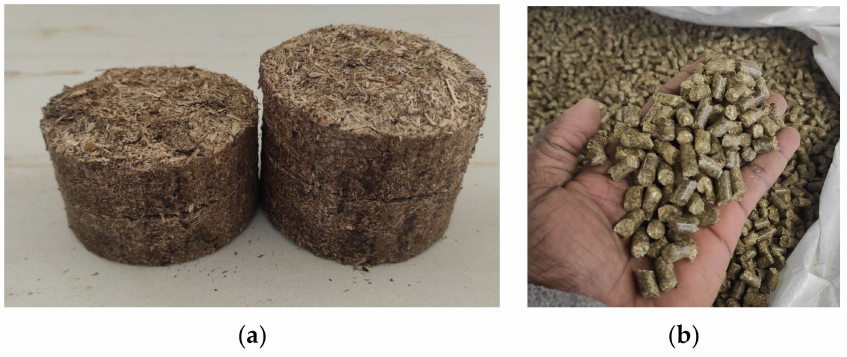
Figure 1. ( a ) Sample of biomass briquettes and ( b ) biomass pellet samples.